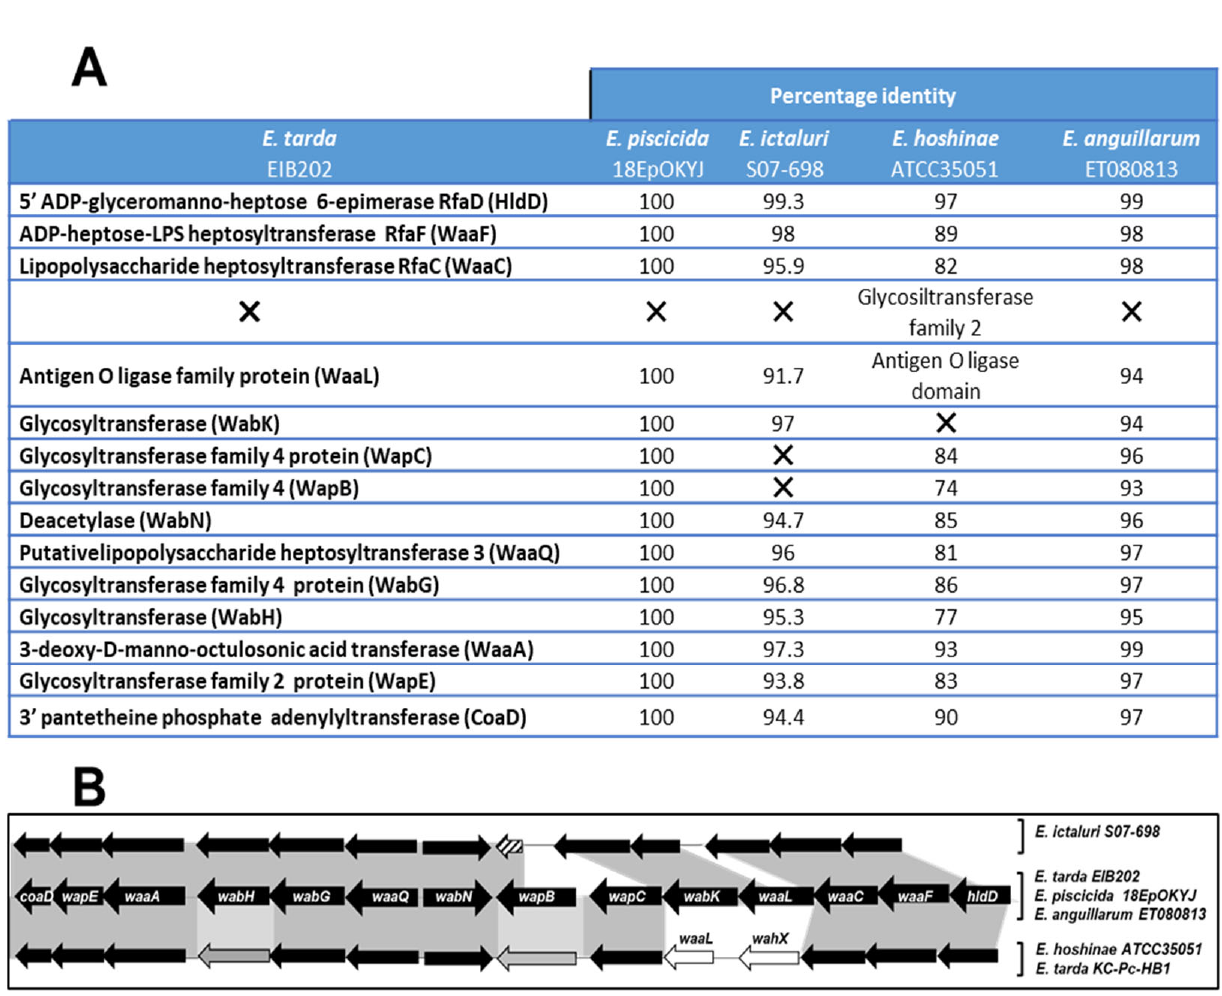
Figure 3. ( A ) Comparison of the proteins present in the waa gene cluster of four different Edwardsiella species. ( B ) Schematic comparison of waa gene cluster models of Edwardsiella. Black arrows and dark gray color between sequences indicate identities higher than 80.0%. Gray arrows and a light gray color between sequences indicate identities higher than 70.0%. White arrows and no color between sequences indicate no identities. Striped arrows indicate deleted genes.